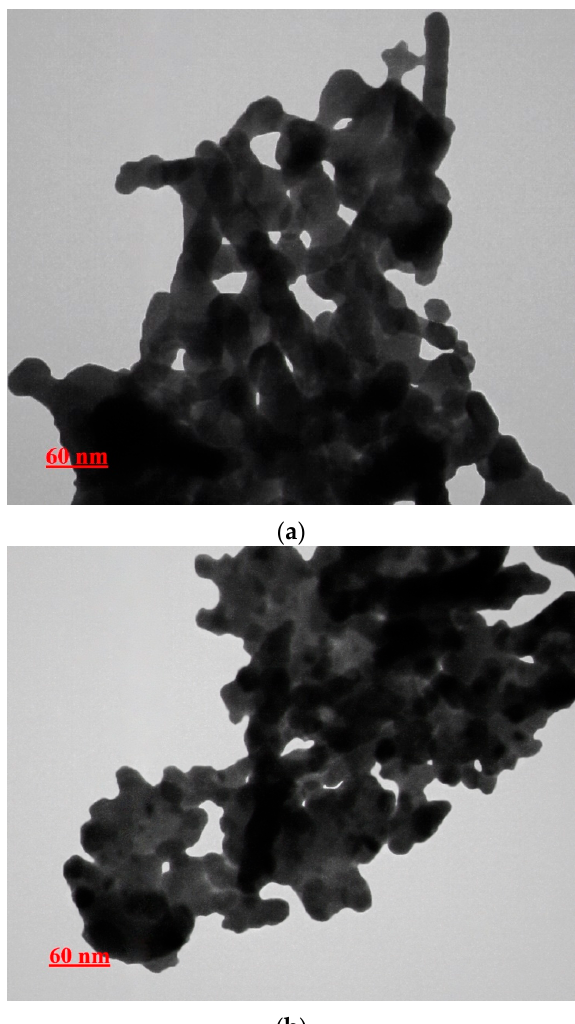
Figure 5. TEM images of fresh: ( a ) Ca ‐ 9Co; and ( b ) Ca ‐ 9Co ‐ 4.5Y.